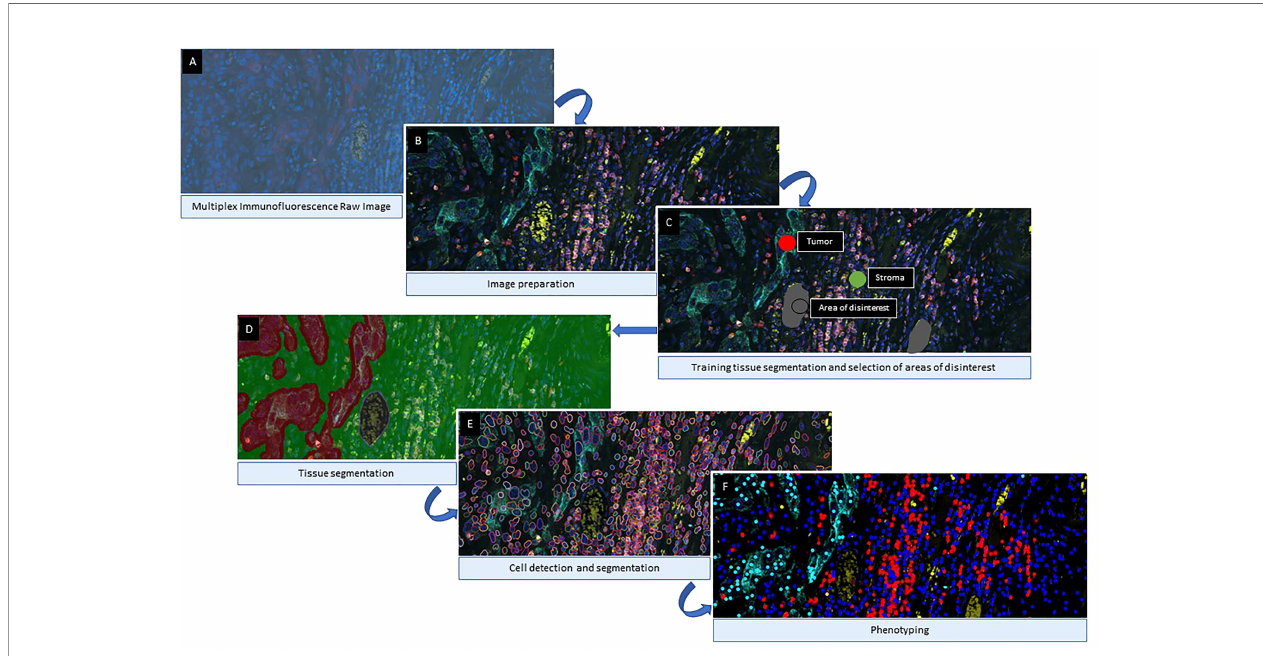
FIGURE 6 | Algorithm Work fl ow of Multiplex immuno fl uorescence Digital Image Analysis. After image scanning, raw images (A) are prepared by activating the fl uorochromes attached to the different cell surface proteins (B) . Then, for tissue compartmentalization, the software user can select the most representative examples of each compartment used during the training algorithm and exclude areas of disinterest (C) . Once the tissue compartment algorithm is applied and the areas are de fi ned (D) , the next step is to de fi ne the cells limits (E) as individual objects to count for the analysis. The fi nal part of the image analysis algorithm is the classi fi cation of the cells based on their phenotypes according to their surface protein expression (F) . Images examples from inForm ® image analysis software. Akoya